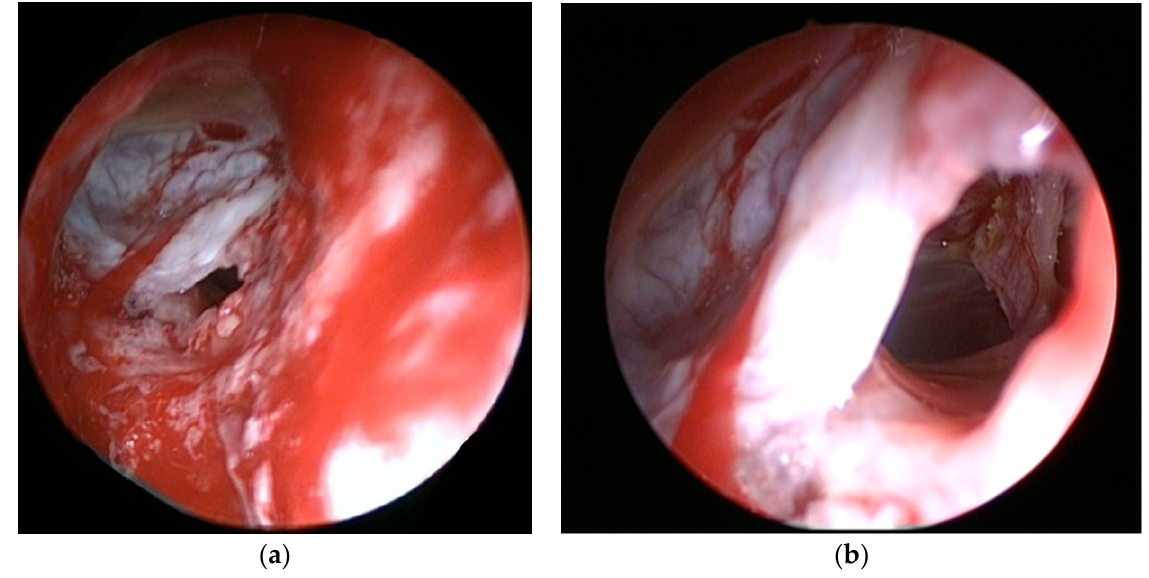
Figure 6. Endoscopic view of a significant bony defect and dural breach on the posterior wall of the frontal sinus ( a ), with intracranial endoscopic view ( b ) (patient no. 6).